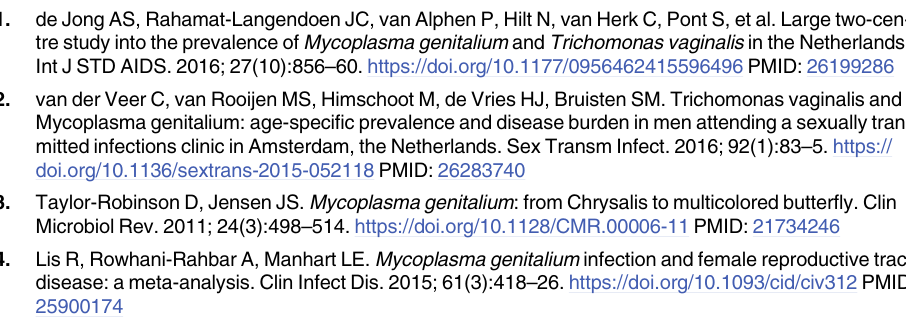
S1 Table. Mycoplasma Genitalium (MG) detection by different molecular techniques and according to anatomical location. S2 Table. Comparison of MG-MRAM qPCR and sequencing analysis to detect MRAM in MG. S3 Table. Prevalence of mutant MG (MG-MRAM) as percentage of typeable samples according to different client characteristics separately for men and